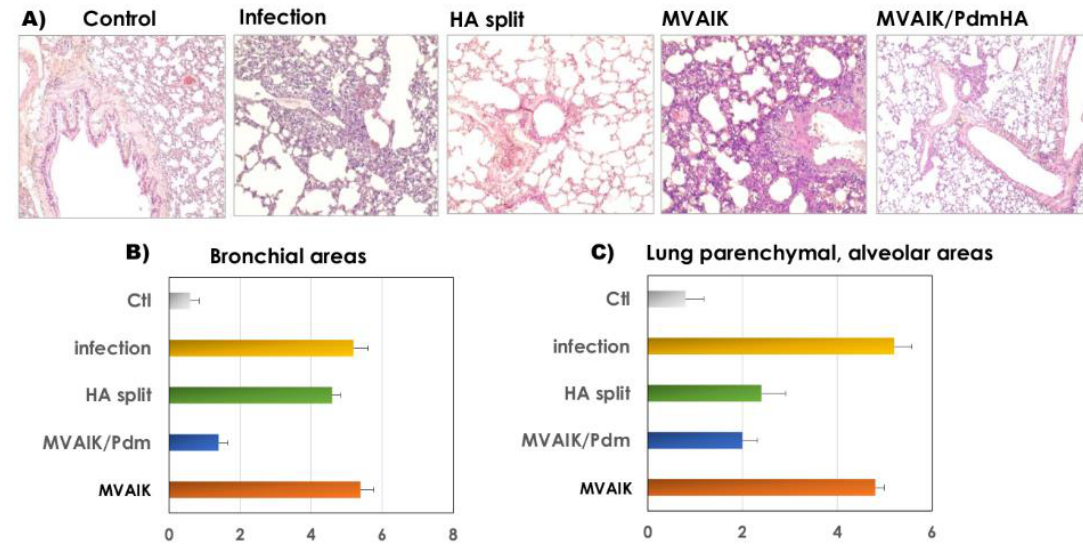
Figure 4. Histopathological findings of cotton rats in control, infection, HA split vaccine, MVAIK (empty vector), and MVAIK / PdmHA groups after challenge. ( A ) HE staining. ( B ) Histopathological scoring in bronchial areas: 2 for mucus and occlusion in the bronchial space, 1 for swelling of alveolar-epithelial cells, infiltration of inflammatory cells in the peri-bronchus, destruction of bronchial epithelial cells, or bleeding in the bronchial space. ( C ) Histopathological scoring in lung parenchymal and alveolar areas: 3 for destruction of the alveolar structure of > 50%, 2 for that of 25–50%, and 1 for that of < 25%, thickening of the alveolar wall, infiltration of inflammatory cells, or bleeding in the alveolar space. Horizontal bar represents mean + SE.